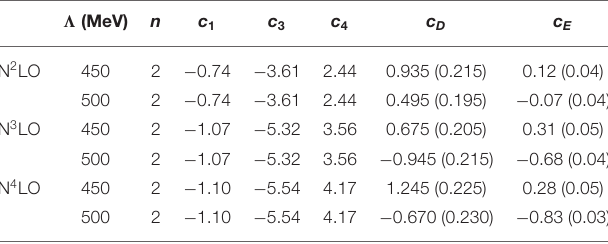
TABLE 1 | Values of the LECs c 1,3,4 , c D , and c E for different orders of the 2NF in the χ EFT expansion, and the 3NF at N 2 LO, and different values of the momentum-space cutoff 3